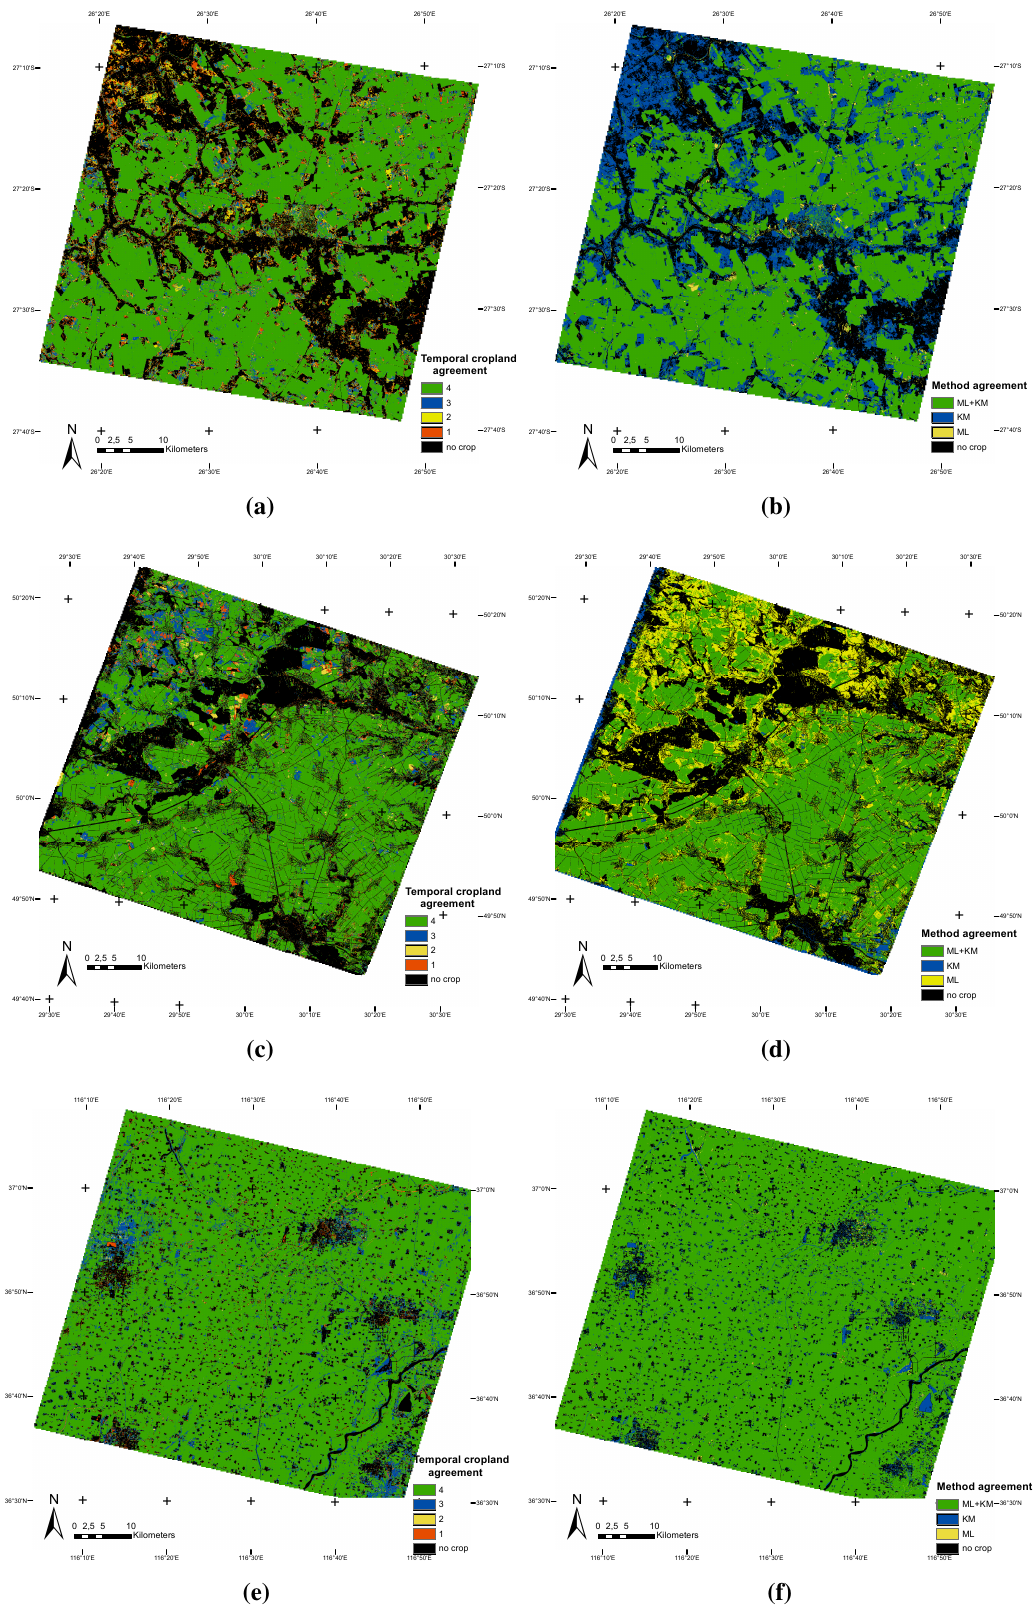
Figure 6. Temporal comparison (left-hand column), displaying the number of cropland detections along the season respectively after three, six, nine and twelve months. Method comparison (right-hand column) in South Africa ( a , b ), Ukraine ( c , d ) and China ( e , f ) between trimming and K-means (0: non-cropland for both classifications; ML: cropland detected only by the maximum likelihood, preceded by the iterative trimming; KM: cropland only detected by the K-means method; ML + KM: cropland identified by both